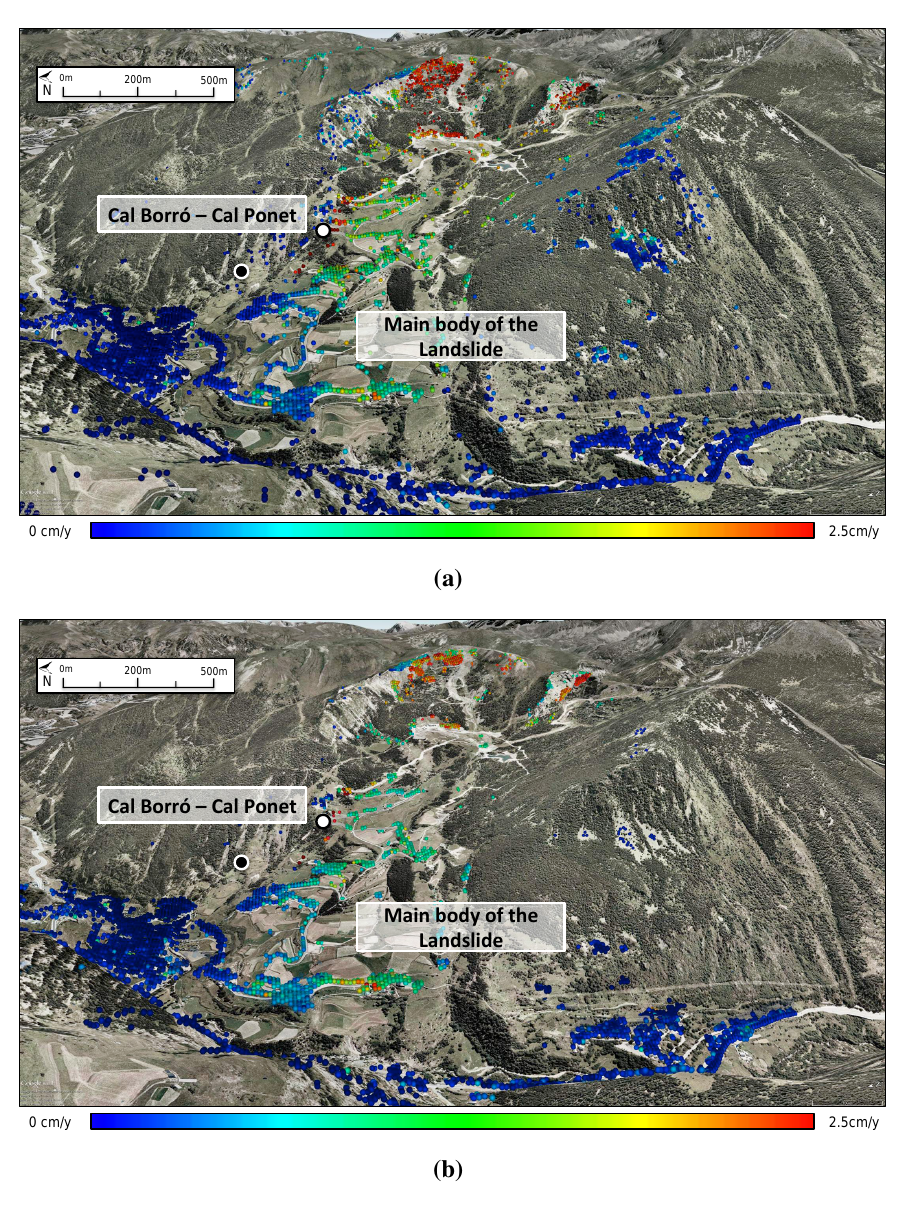
Figure 14. Geocoded down-slope linear displacement corresponding to El Forn de Canillo using ( a ) the TSC and ( b ) the coherence stability approach for the TerraSAR-X dataset. The black spot indicates the location of the seed employed during the integration step. The white spot indicates the location of the inclinometer S10, which will be employed as ground-truth to validate the